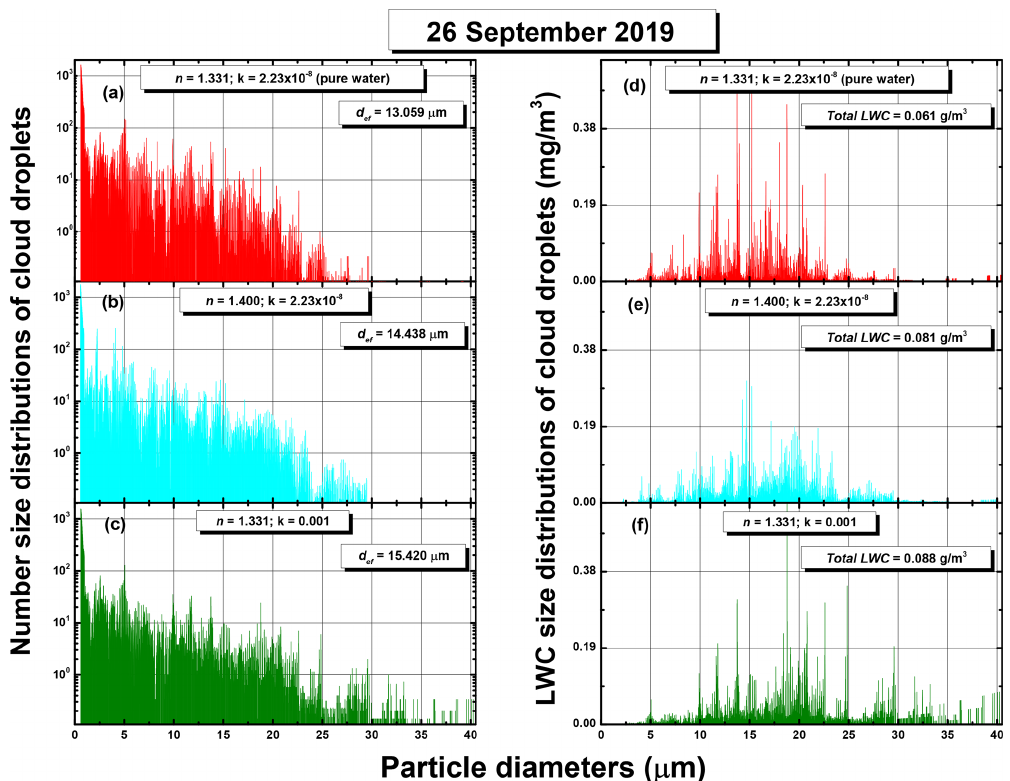
Figure 10. Effect of eventual variations in the refractive index on the detailed number (a–c) and LWC (d–f) size distributions illustrated on data collected in a flight line performed on 26 September 2019, over some part of Romania. Panels (a) and (d) are constructed using the refractive index of pure water. Both distributions shift to the right when either the refractivity (b, e) or the absorption (c, f) increase, indicating that using optical parameters of pure water leads to underestimations in both size and LWC. While the effective diameter, indicated in panels (a) – (c) , is underestimated with 10% to 15%, the underestimation of the total LWC, indicated in panels (d) – (f) , runs between 25% and 30% when assuming optical parameters of pure water for contaminated